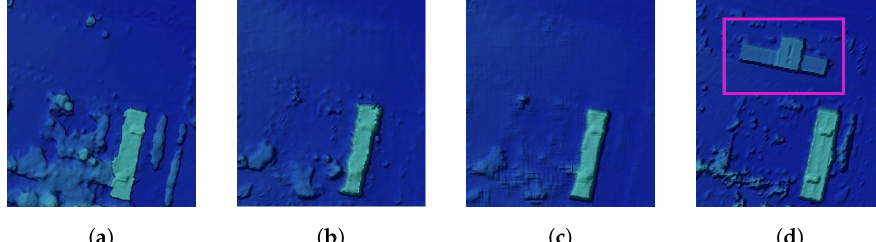
Figure 7. Demonstration of generalization of existed buildings in the input DSM using both cGAN and cLSGAN methodologies trained on LIDAR ground truth data. ( a ) illustrates the input stereo DSM, ( b ) is a generated DSM using cGAN, ( c ) is a generated DSM using cLSGAN, and ( d ) is a LIDAR ground